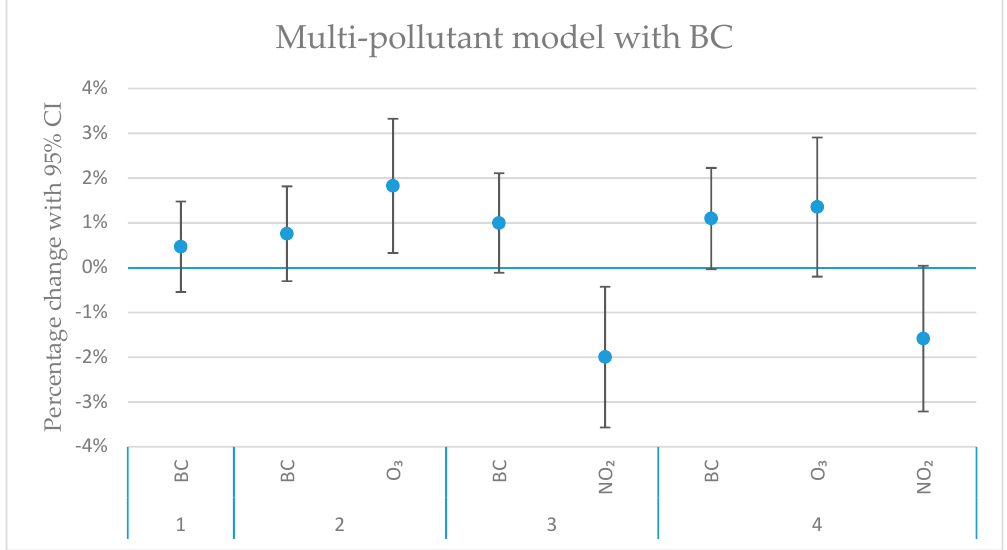
Figure 6. The estimated change in daily mortality (with 95% CI) for an IQR increase in concentration (lag02) of BC, O 3 and NO 2 in a multi-pollutant model. Model 1 (furthest to the left) represents the single-pollutant estimate of BC. Model 2 and 3 represent two-pollutant models, with O 3 (Model 2), and with NO 2 (Model 3). In Model 4, both BC, O 3 and NO 2 are included.